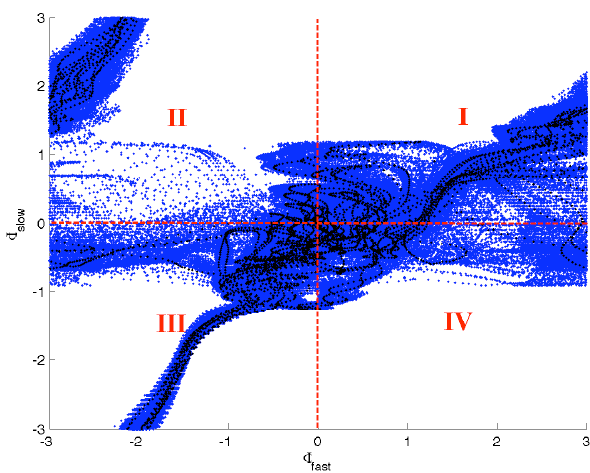
Fig. 8. Phase 8 slow (slow model) against 8 fast (fast model). Blue dots are ensemble members, black dots ensemble